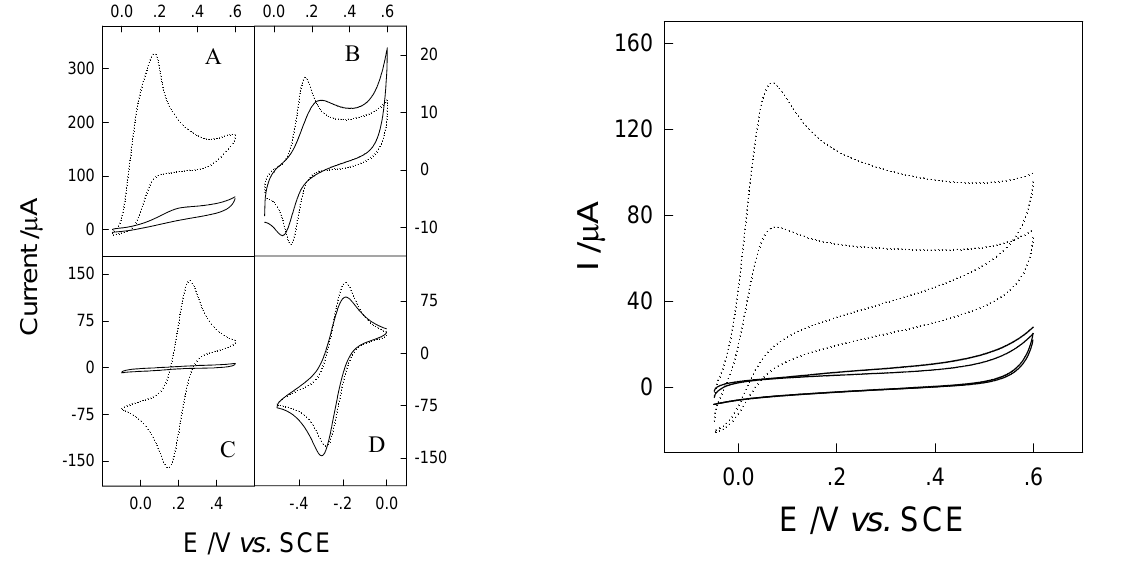
Figure 4 (left) . Cyclic voltammograms of 5.0 mM ascorbic acid (A), 0.1 mM dopamine (B), 5.0 mM ) 63+ (D) in PBS buffer (pH 7.4) at bare (dashed lines) and 300 Hz Fe(CN) 63- (C) and 5.0 mM Ru(NH 3 PPY/TA film-modified Au electrodes (solid